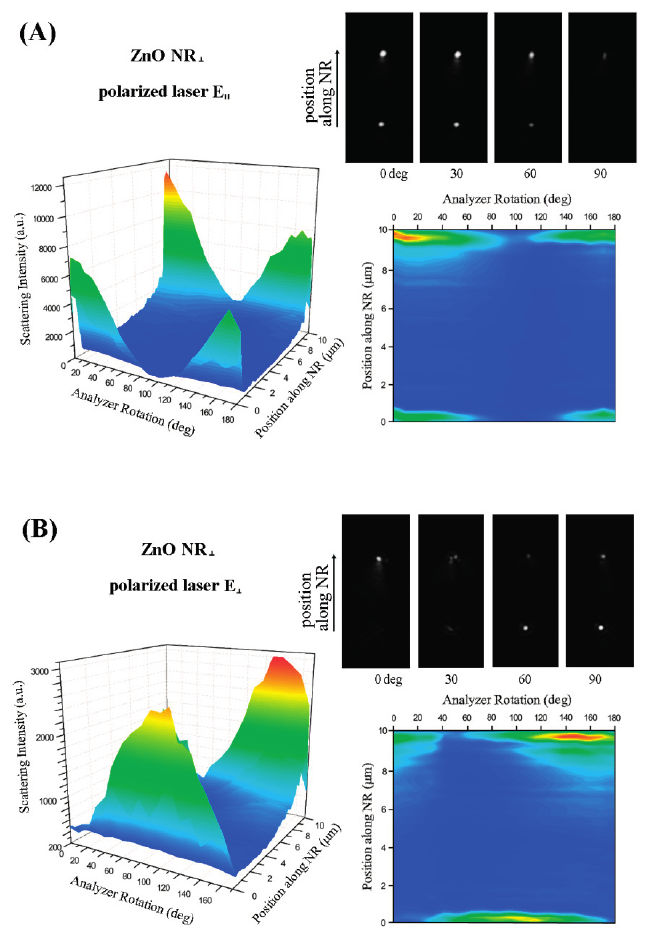
Figure 4. Scattering of a single ZnO NR (184 nm in diameter, 10.15 μ m in length) measured by using two polarization directions of an incoming laser ( E ║ and E ┴ ) on an NR oriented along the x-axis (ZnO NR ┴ ). Scattering intensity was measured with respect to the position along the length of the 1D nanomaterial as well as the analyzer angle. ( A ) The 3D contour plot summarizes scattering results from a ZnO NR ┴ under the excitation of E ║ as a function of both the analyzer angle and the spatial position on the NR. A striking difference in the scattering signal was seen along the length of the NR ┴ . Intense scattering occurred only on the two ends of the NR ┴ where the signal along the main body of NR ┴ was negligible. This phenomenon is also clearly seen in the 2D projection of the scattering intensity with respect to the analyzer angle at each position along the length of the ZnO NR ┴ . Color schemes used in the 2D plot are the same as the scattering intensity levels profiled in the 3D contour graph. A series of grey-scale panels are the scattering images obtained from the ZnO NR measured at the analyzer angle of 0°, 30°, 60°, and 90°, respectively. ( B ) The same set of scattering measurements was repeated by using the orthogonal excitation of E ┴ as a function of both the analyzer angle and the spatial position on the same ZnO NR ┴ shown in